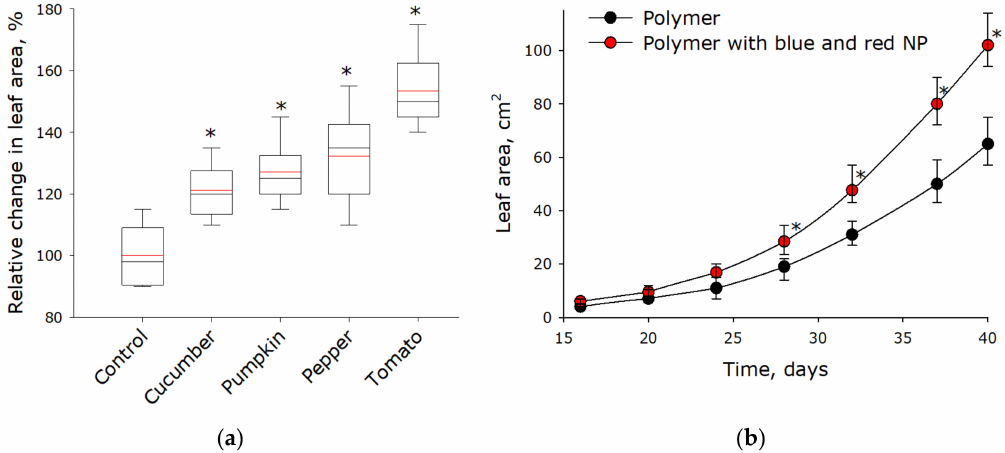
Figure 4. Influence of a photoconversion fluoropolymer film on the growth and development of plants of di ff erent species. ( a ) E ff ect of photoconversion polymer film on the leaf size of cucumber ( Cucumis sativus ), pumpkin ( Cucurbita pepo ), pepper ( Capsicum annuum L.), tomato ( Solanum lycopersicum ) plants. Control values are normalized. Data are presented as median with 95% confidence interval (box). The range is shown in the form of a whiskers. Statistically significant di ff erences between control group and other groups (Mann-Whitney U test, p < 0.05) are marked by asterisks. ( b ) Dynamics of changes in the leaf area of control tomato plants and tomato plants grown under a photoconversion polymer film. Statistically significant di ff erences between control group and other groups (Mann-Whitney U test, p < 0.05) are marked by